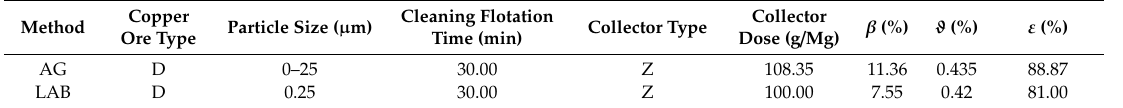
Table 17. The results obtained for the analysis of all cases in the Jameson